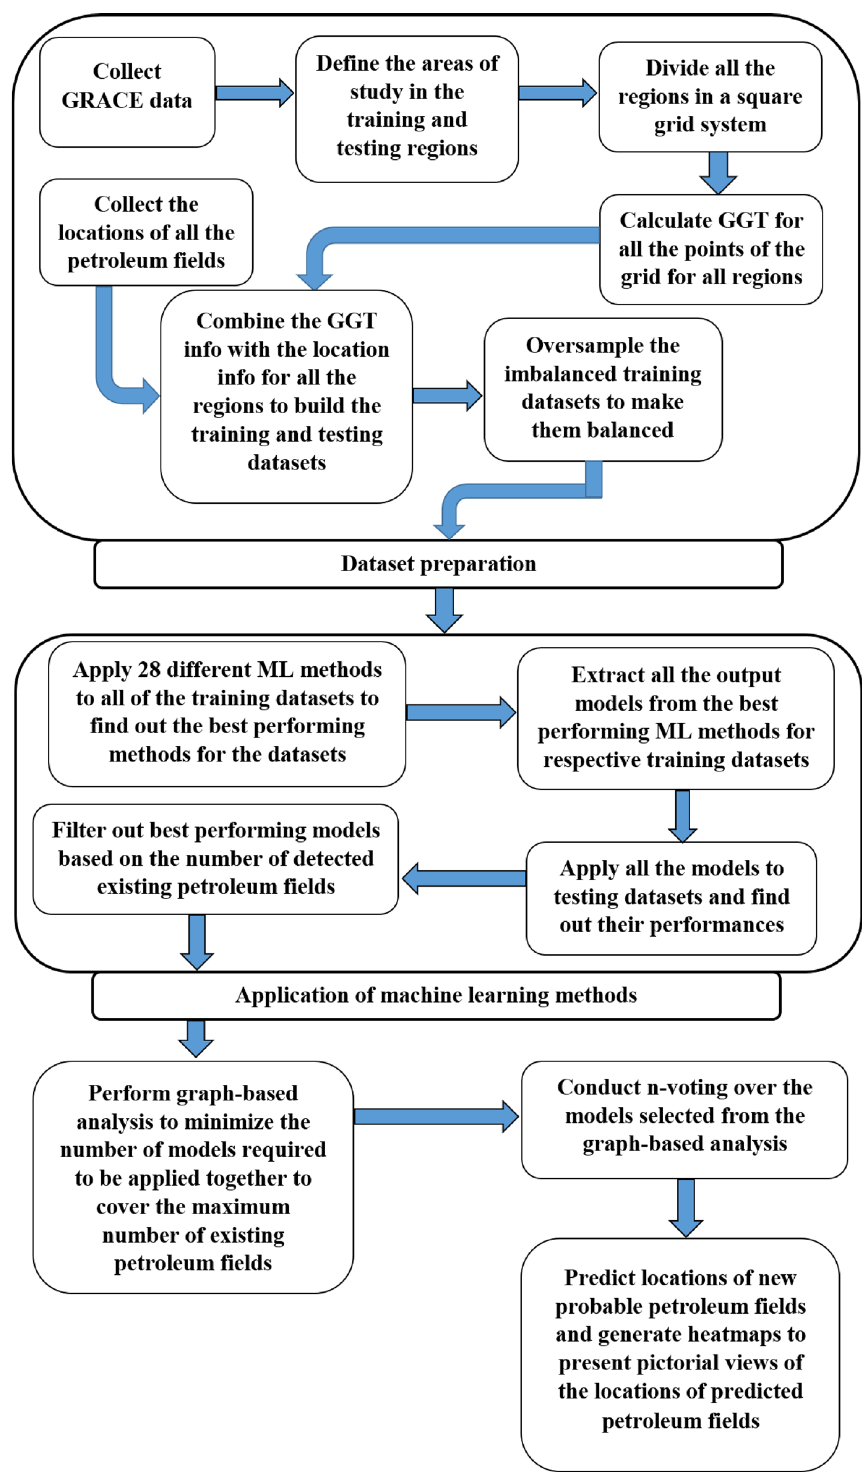
Figure 1. Methodology and different steps performed in the